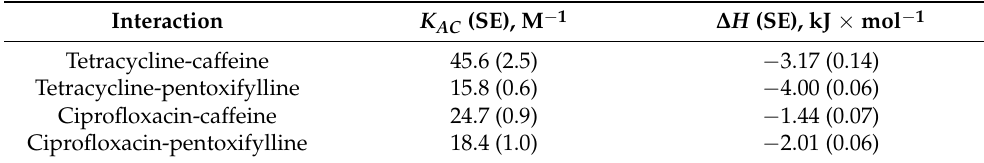
Table 2. Determined thermodynamical parameters of antibiotic-xanthine hetero-complex formation. Interaction